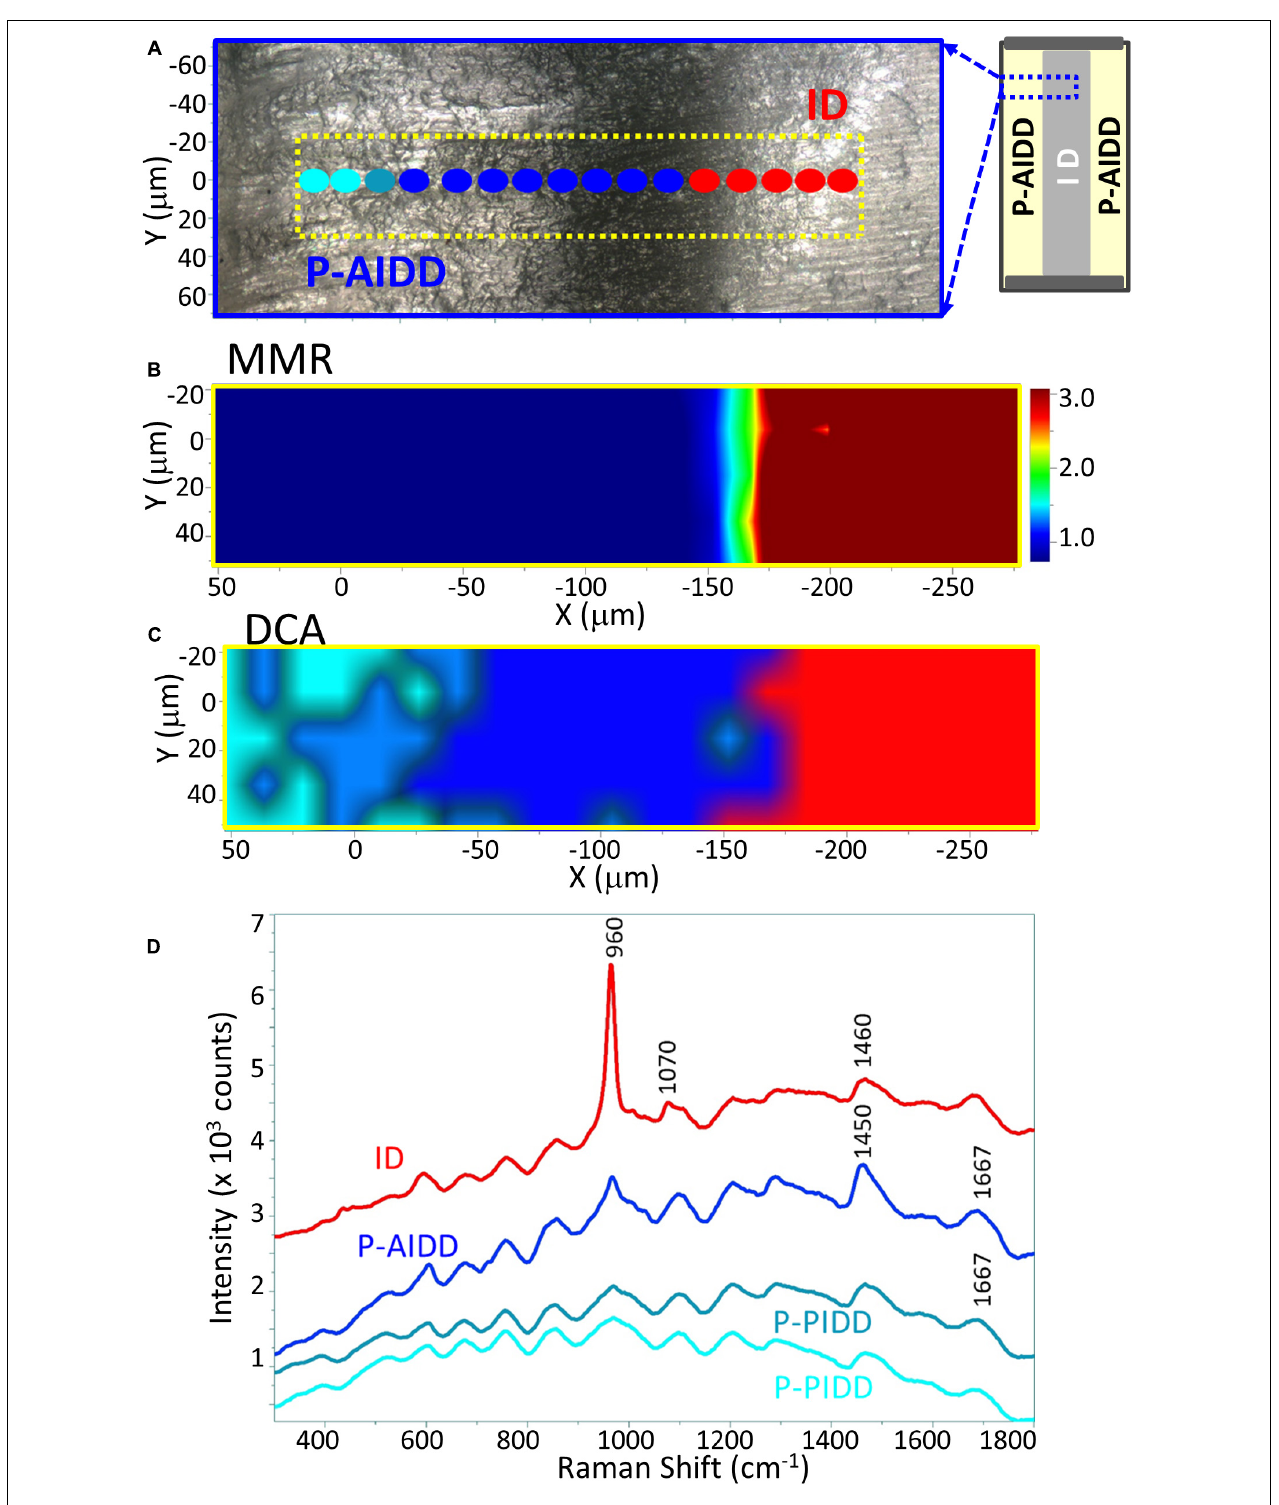
FIGURE 4 | Raman analysis of a representative peptide-functionalized adhesive-infiltrated demineralized dentin (P-AIDD) specimen. (A) Light micrograph marked with a X-Y scan area, (B) µ -Raman mineral map (MMR) of the X-Y scan area. (C) K-means clustering map (DCA) of the Raman profile of the same scan area. Four classes are identified, including intact dentin (ID), peptide-functionalized adhesive-infiltrated demineralized dentin (P-AIDD) and two peptide-functionalized partially-infiltrated demineralized dentin (P-PIDD) regions with similar spectral features. (D) Raman spectra from the four classes.